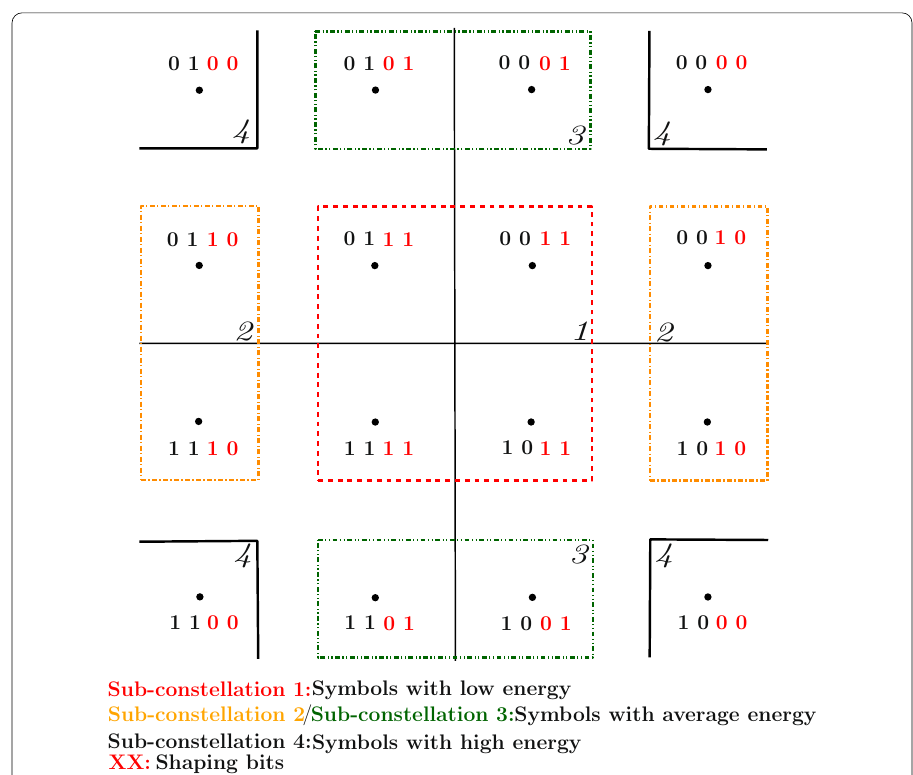
Fig. 5 Constellation mapping for shaping technique